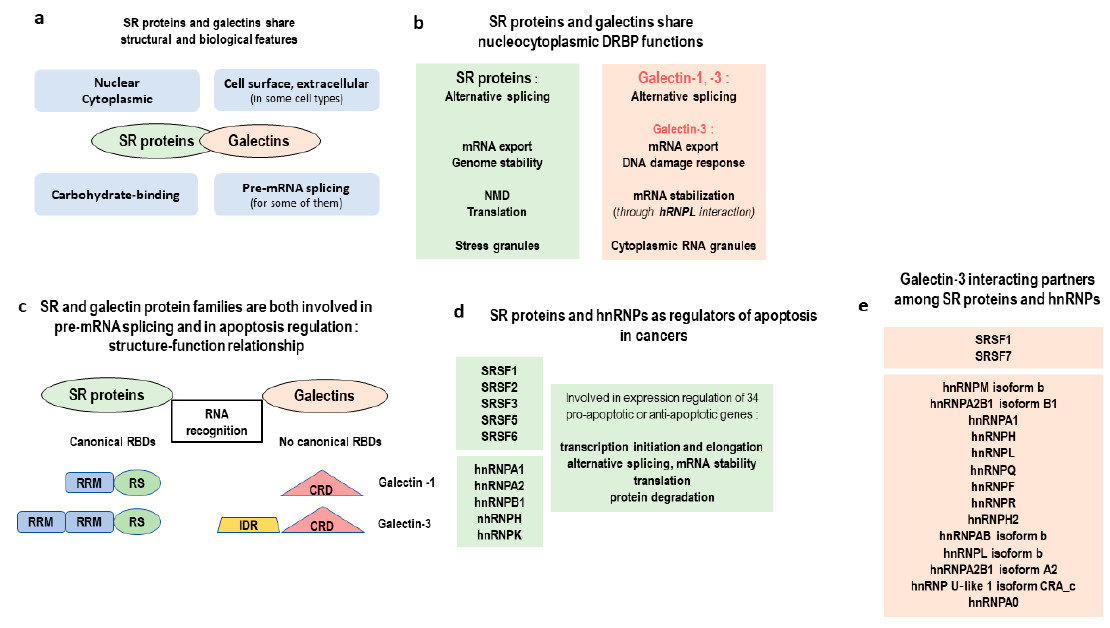
Figure 4. Towards a network of RBPs involved in apoptosis regulation. ( a ) As early as 2010, Haudek et al. [118] highlighted four striking similarities (in blue rectangles) between the general features of two protein families, SR (serine arginine rich) proteins (previously known as splicing factors) and galectins (previously known as animal lectins binding β -galactoside motifs found in many glycoproteins and glycolipids). They share a large intracellular and extracellular distribution, potentially indicating their involvement in large cellular processes with broad functions. ( b ) SR proteins and two members of the galectin family, galectin-1 and galectin-3, are expressed in the nucleus and involved in pre-mRNA splicing. However, SR proteins and galectin-3 share some other striking features, such as shuttling between the nucleus and cytoplasm and involvement in genome stability [120,122–126]. The RBP role of galectin-3 is mediated through the hnRNPL interaction, as shown by Coppin et al. [120]. ( c ) SR proteins harbor two RBDs, RRM (RNA recognition motif, a canonical RBD) and SR (an RBD with some Intrinsically Disordered Regions (IDRs)). Galectin-1 and galectin-3 harbor a carbohydrate-recognizing domain (CRD) but no RBD. However, galectin-3 harbors an IDR. ( d ) SR proteins and hnRNPs regulate the alternative splicing of pre-mRNAs involved in the expression of pro-apoptotic or anti-apoptotic variants, thus influencing their balance in cancer cells. Besides their role in alternative splicing, they are also involved in all stages of the expression regulation of 34 target genes involved in apoptosis regulation [64]. ( e ) 84 nuclear binding partners of galectin-3 were identified by Fritsch et al. through galactose interaction assay [121], making them interesting targets in studying new galectin-3 functions. In this report, two Serine/Arginine-rich splicing factors (SRSFs) and 14 hnRNPs, including hnRNP-L, are found. Thus, galectin-3 is thought to act as a major player in large cellular processes, including mitosis and DNA damage response, transcription and translation, apoptosis, and responses to stress